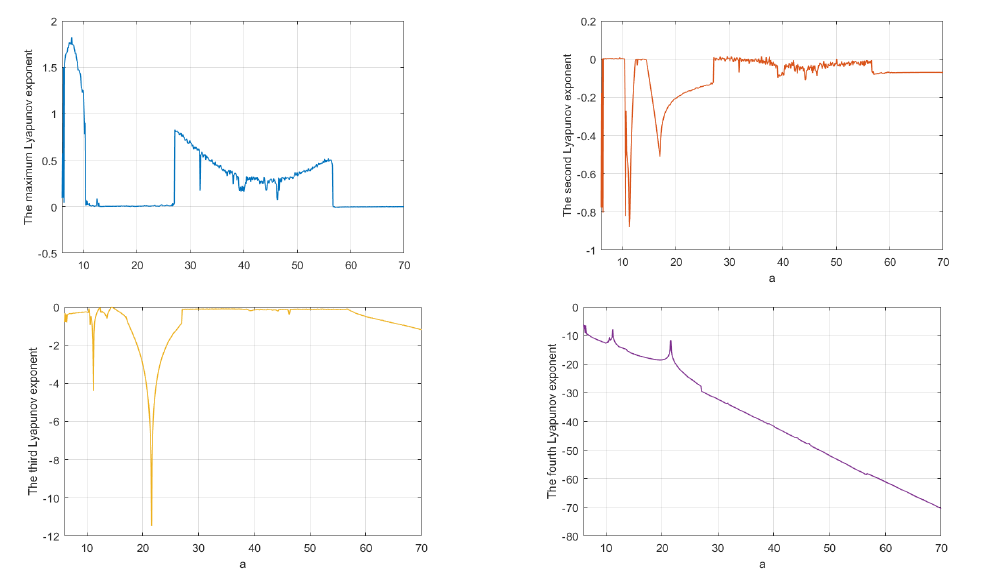
Figure 5. Spectrum of Lyapunov exponents for a ∈ [ 6,70 ] .